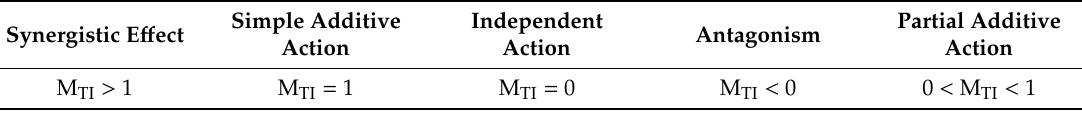
Table 1. Criteria for the types of combined toxic action in the